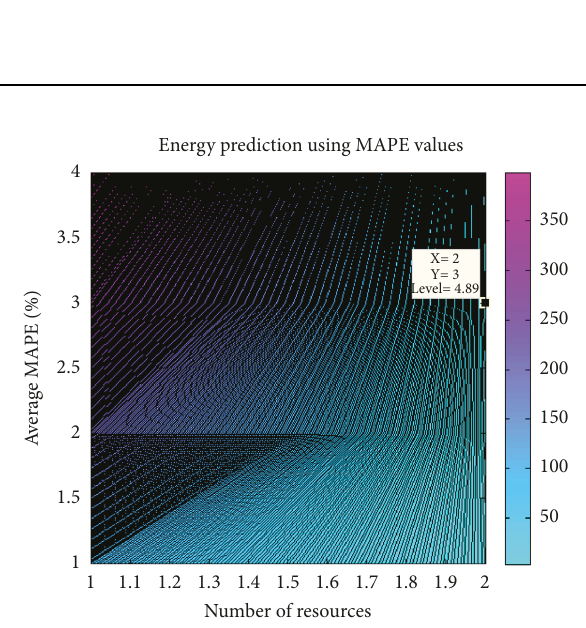
Figure 8: MAPE values in energy prediction. Table 4: Comparison of R 2 for the selected algorithms. Table 3: R 2 values in the energy prediction.